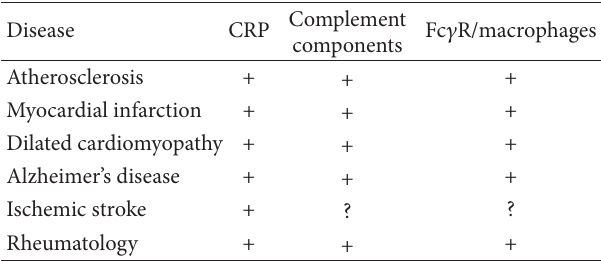
Table 1: Colocalization of CRP, complement components, and Fc 𝛾 R/macrophages as a general feature in histopathology of human